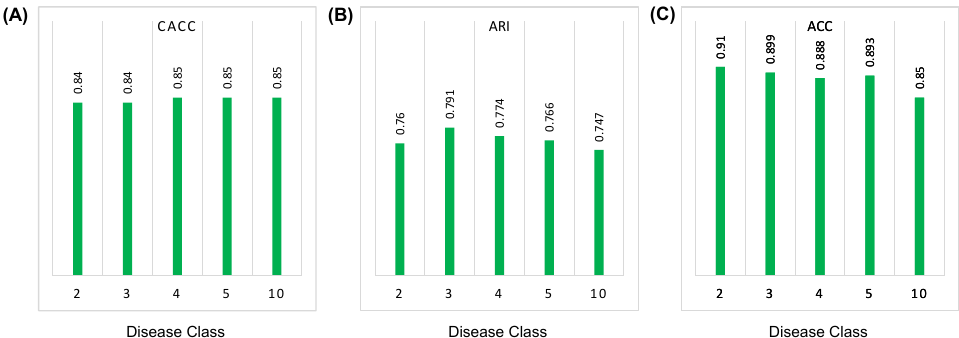
Figure 8. Comparison of the performance of the proposed model with respect to the different number of classes. ( A – C ) exhibits benchmark results based on CACC, ARI, and ACC metrics, respectively. The horizontal axis represents the number of classes, and the vertical axis represents the scores of the corresponding